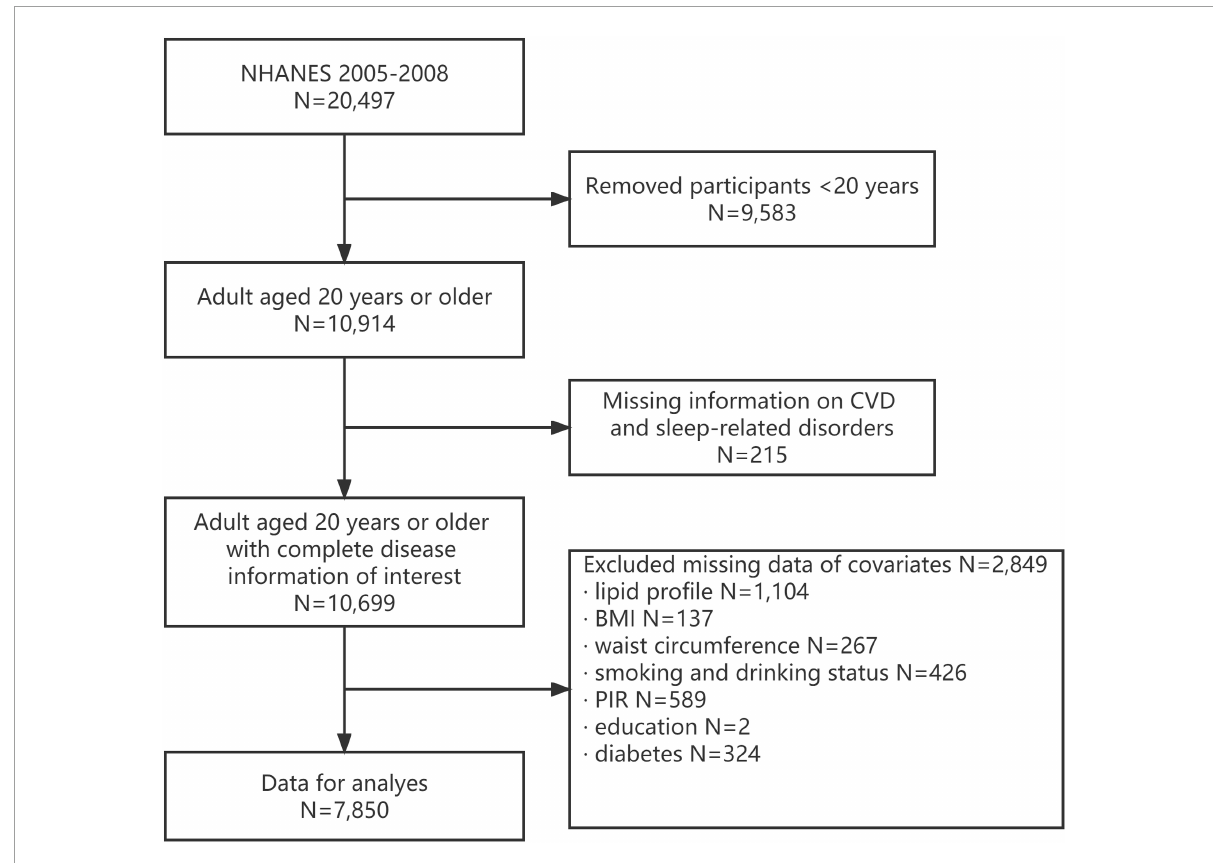
FIGURE1 Flow chart of eligible National Health and Nutrition Examination Survey (NHANES) participants included in this